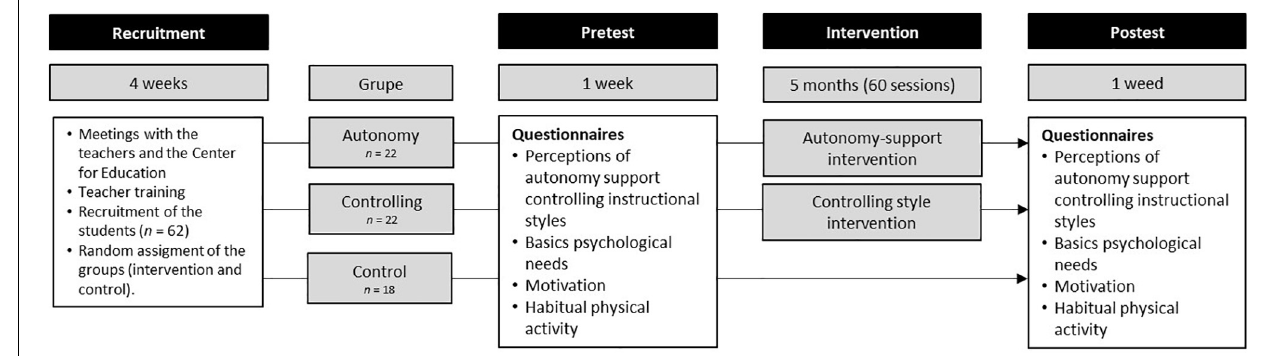
FIGURE 1 | Design of the study.